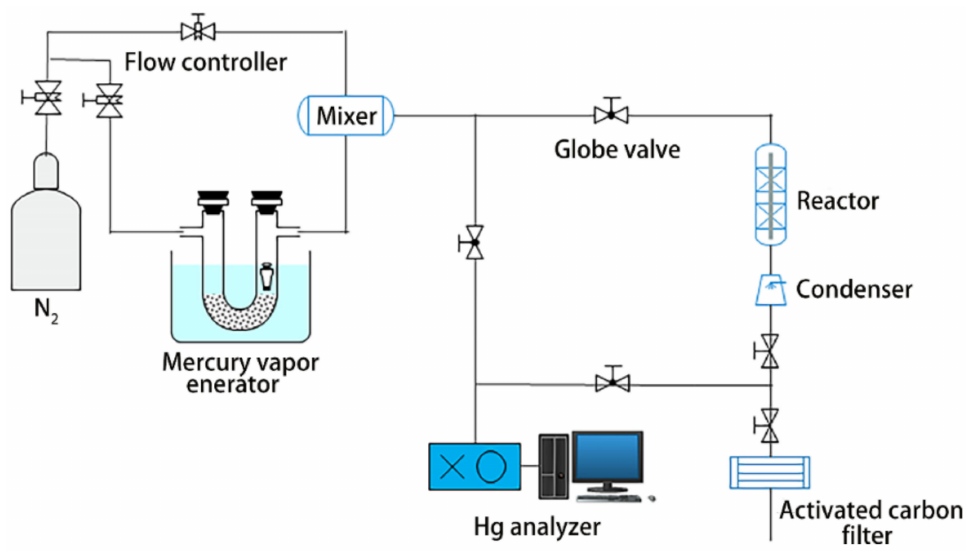
Figure 1. Schematic diagram of the mercury adsorption